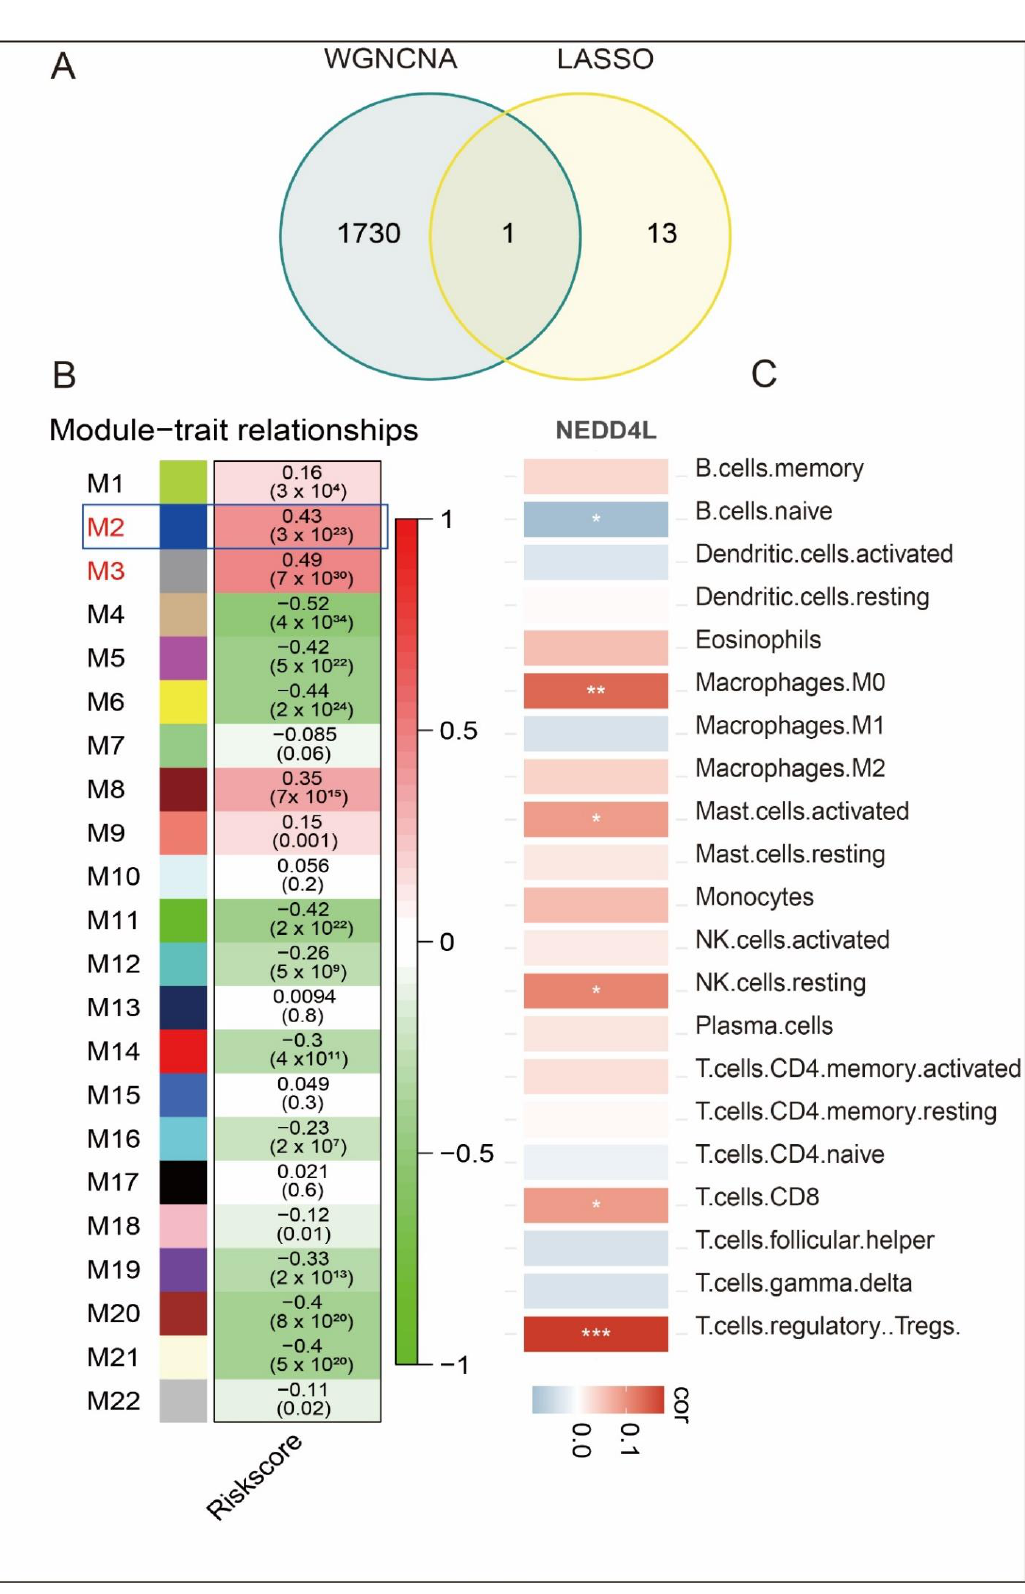
Figure 5. Identification of one hub gene and prediction of their relationship with immune cell. ( A ) Venn diagram analysis showed that the overlap of WGCNA analysis and LASSO model led to one hub gene being identified: NEDD4L. ( B ) Heatmap of model trait relations. ( C ) Prediction of correlations between hub genes and immune cells. * p < 0.05; ** p < 0.01; *** p <